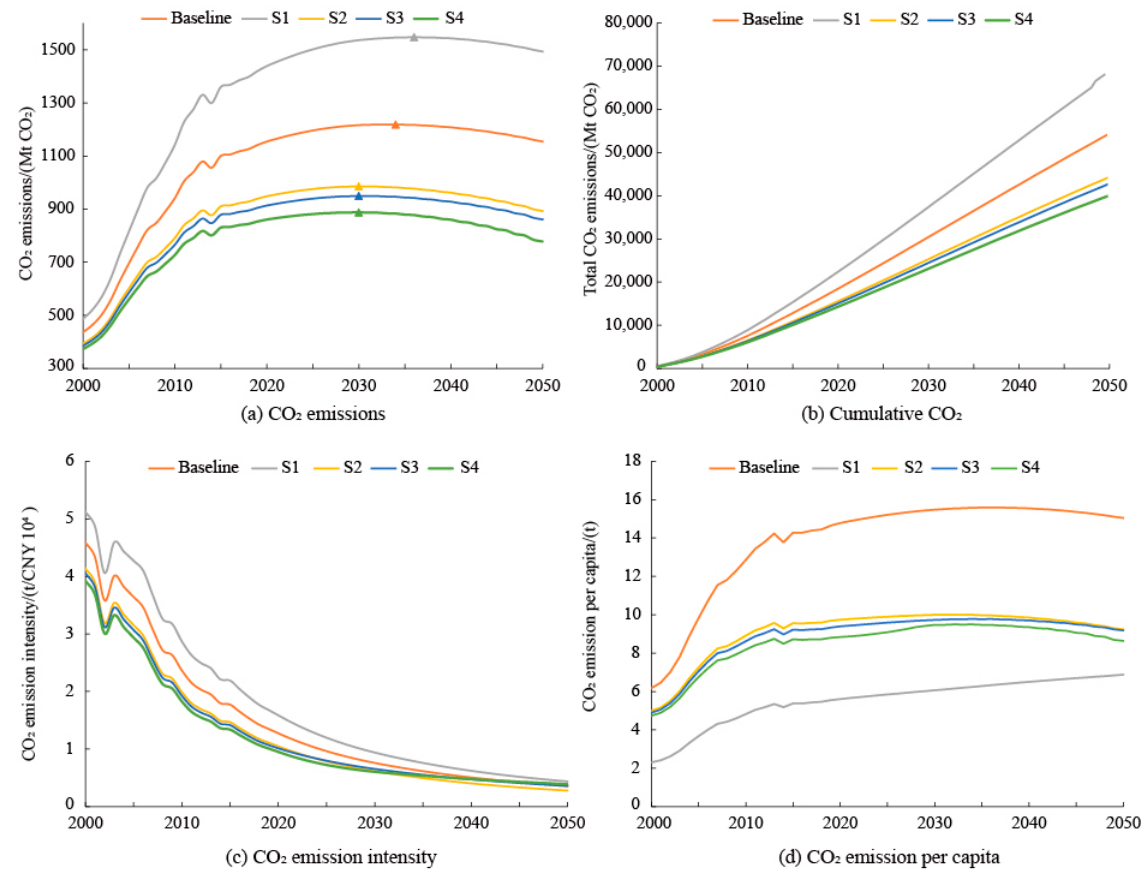
Figure 6. Simulation results of CO 2 emission ( a ), cumulative CO 2 ( b ), CO 2 emission intensive ( c ) and CO 2 emission per capita ( d ) in S1, S2, S3, S4 and baseline scenario.